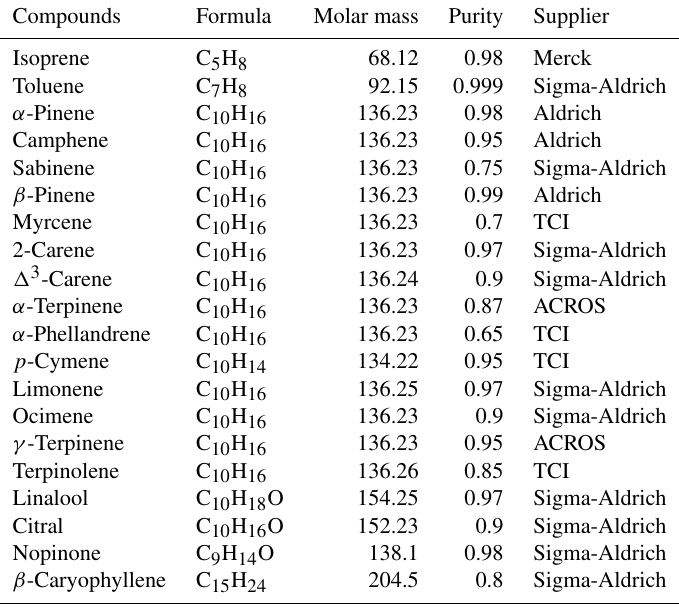
Table 2. List of target species for ambient measurements and chemical properties for gas standard generation. Compounds